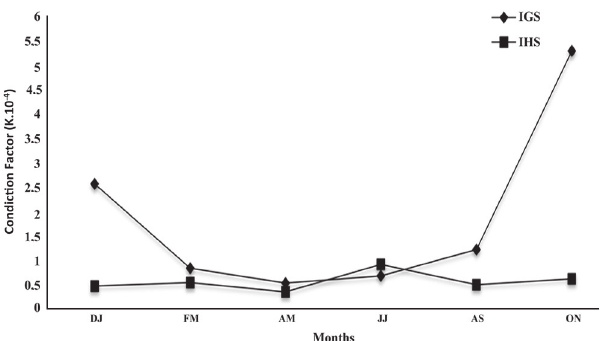
Fig. 10. Bimonthly variations in the gonadosomatic index (GSI ) and hepatosomatic index (HSI ) for Loricariichthys melanocheilus females in the rio Ibicuí, Rio Grande do Sul.